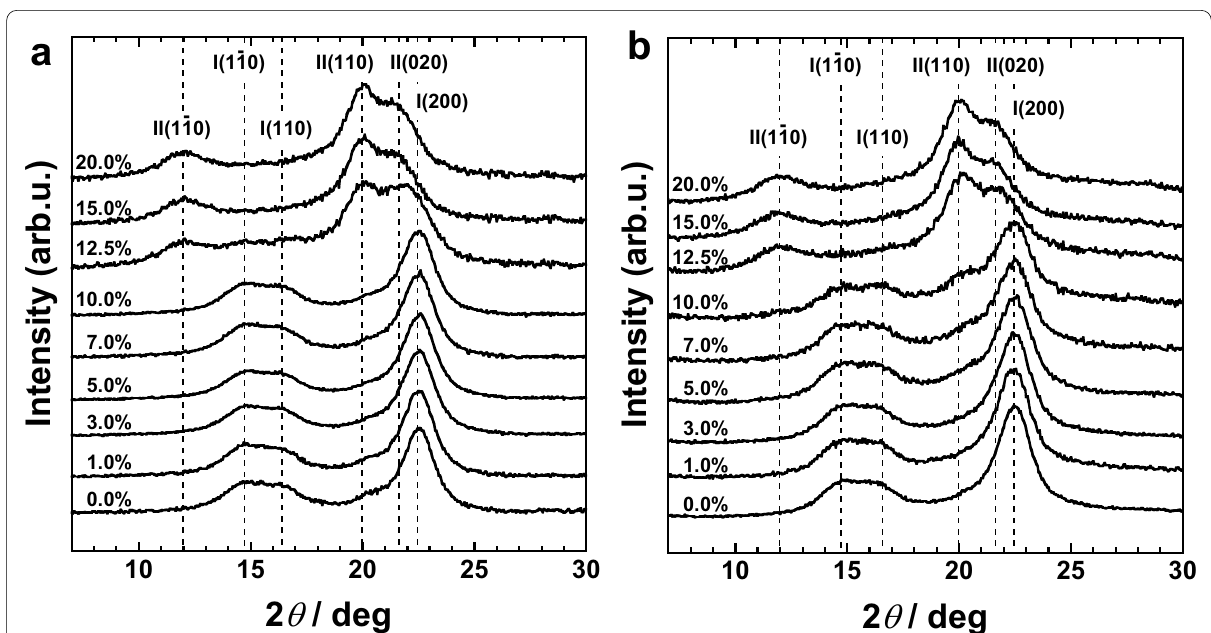
Fig. 1 WAXD profiles of a initial MCC powders and b ACC-CNFs treated with varying concentrations of aqueous NaOH. NaOH concentration: 0.0, 1.0, 3.0, 5.0, 7.0, 10.0, 12.5, 15.0, and 20.0